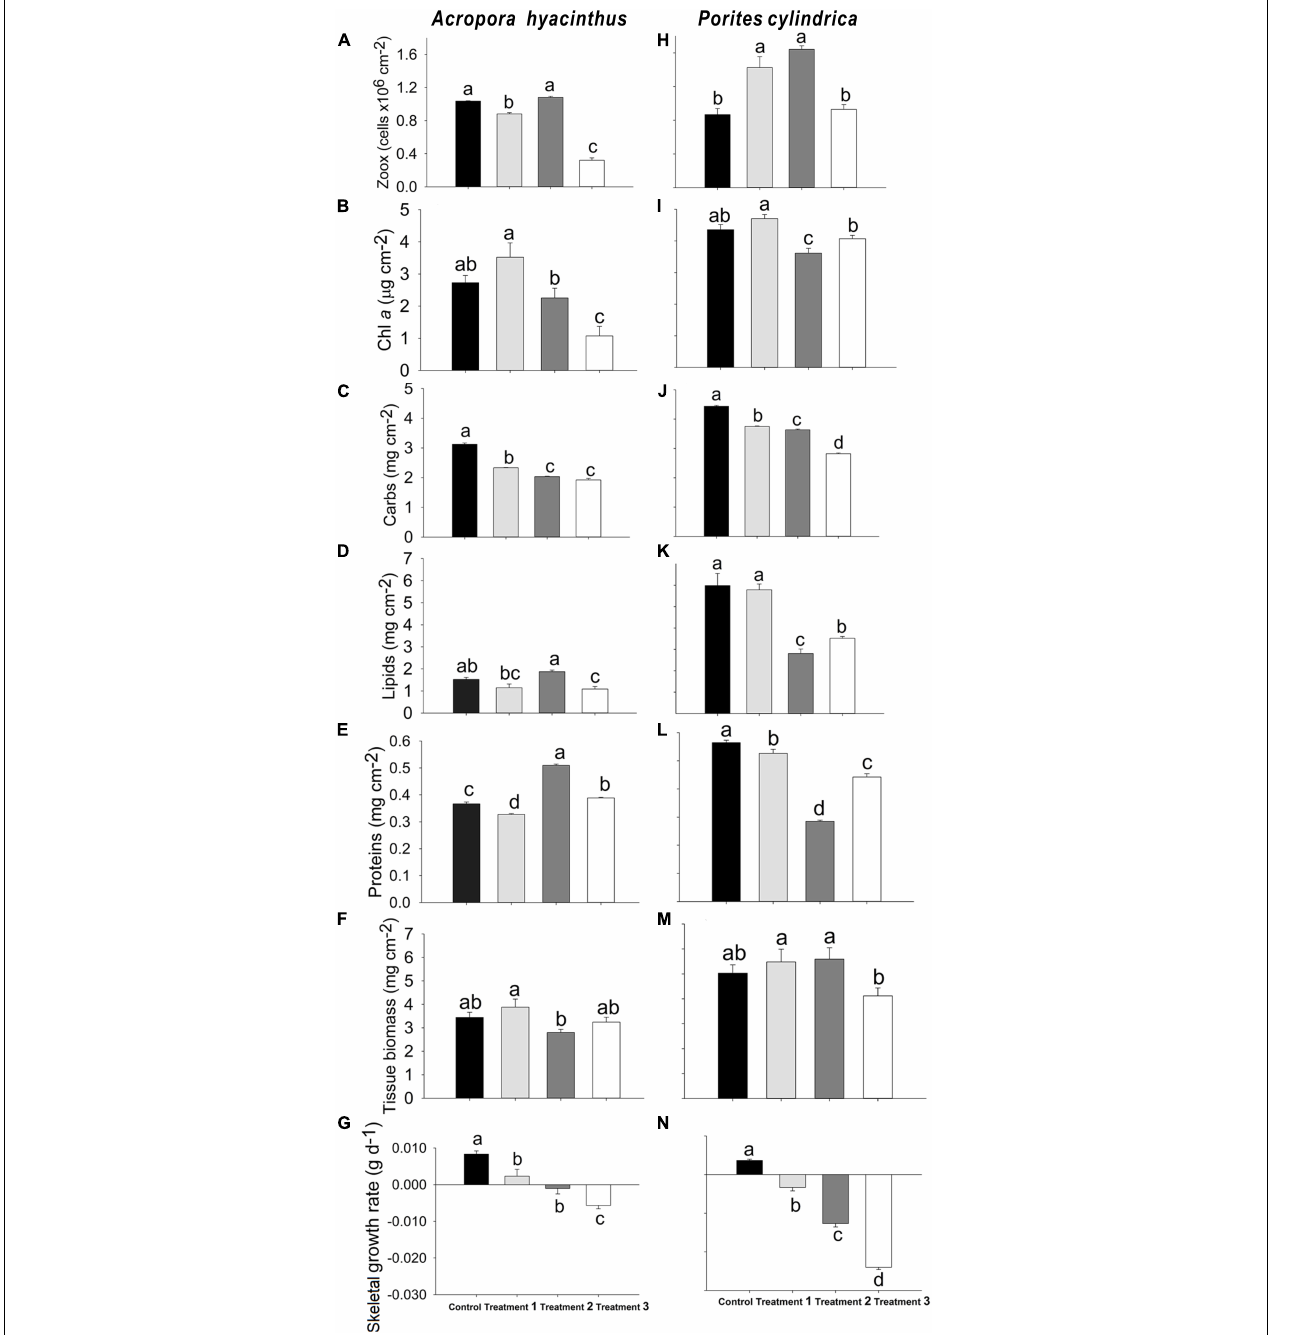
FIGURE 4 | Average (A,H) zooxanthellae density (Zoox), (B,I) Chl a concentration, (C,J) carbohydrate concentration (Carbs), (D,K) lipid concentration, (E,L) protein concentration, (F,M) tissue biomass, and (G,N) skeletal growth rate in the control group and three treatment groups (1 = touching, 2 = touching, and ammonia nitrogen enrichment, 3 = touching, ammonia nitrogen enrichment, and sediment cover) for A. hyacinthus and P. cylindrica . Each bar represents the mean of three samples ± SD (standard deviation). The data with different letters above bars are significantly different at P < 0.05 level.